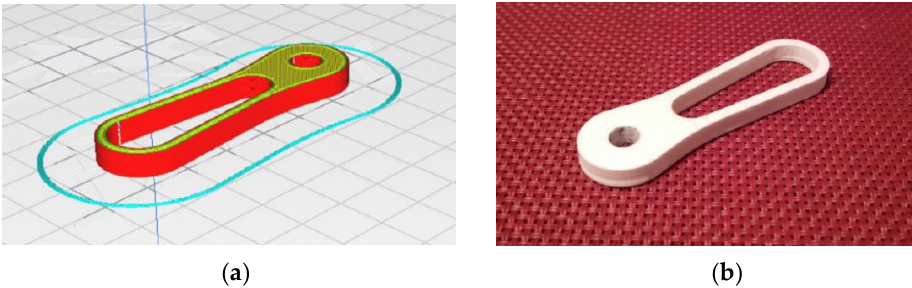
Figure 3. Servo motor first servo arm: ( a ) Visualization in Ultimaker Cura software; ( b ) Actual 3D print.